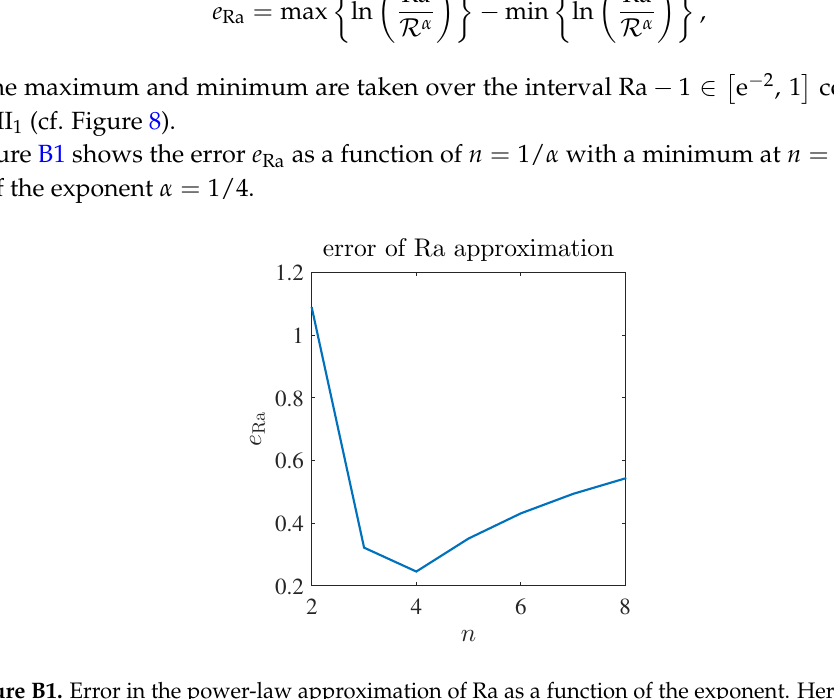
Figure B1. Error in the power-law approximation of Ra as a function of the exponent. Here, n = 1/ α is chosen to be an integer: n = 2, 3, 4, 5, 6, 7,